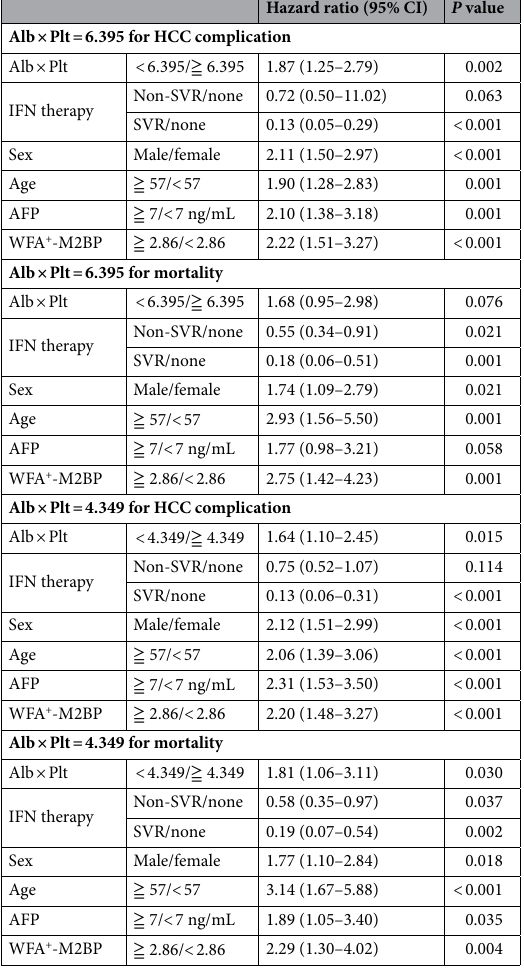
Table 3. Prediction of HCC prevalence and mortality by Albumin platelet product in a validation cohort. HCC hepatocellular carcinoma, IFN interferon, SVR sustained viral response, 95% CI 95% confidence